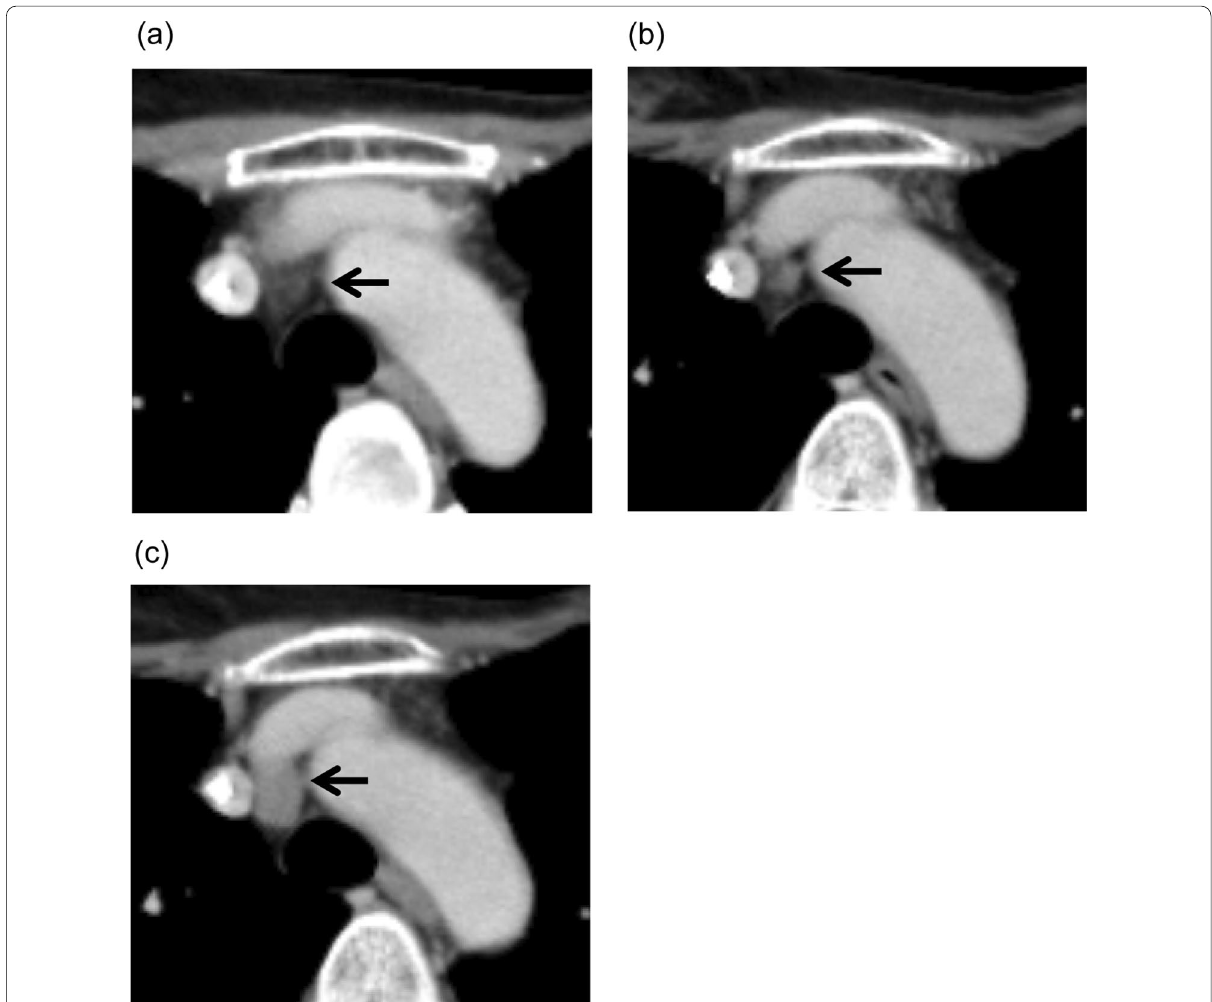
Fig. 3 Chest CT scans obtained in the a first year, b second year, and c third year after surgery. The scans showed that the mediastinal nodule had been gradually growing for 3